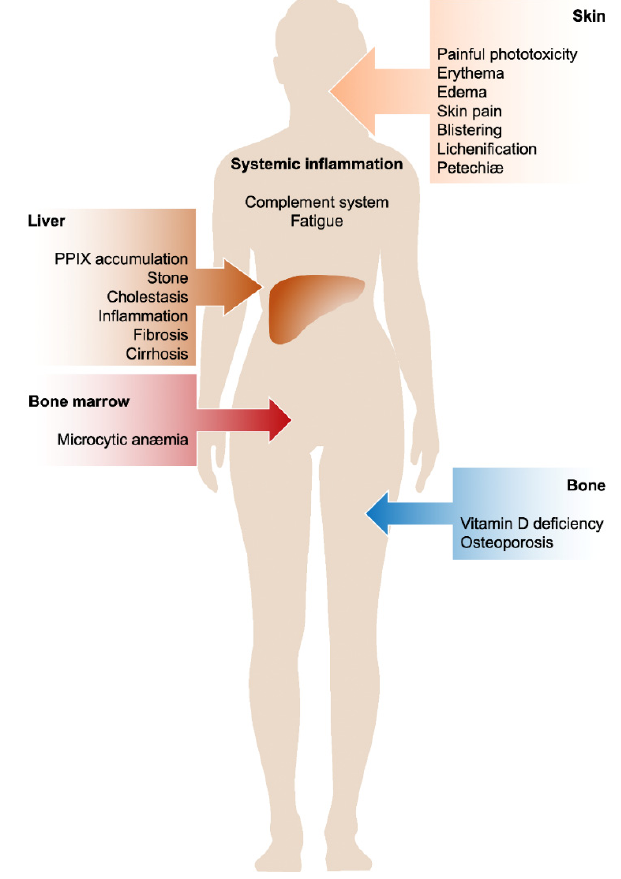
Figure 3. Multi-organ involvement in protoporphyria.